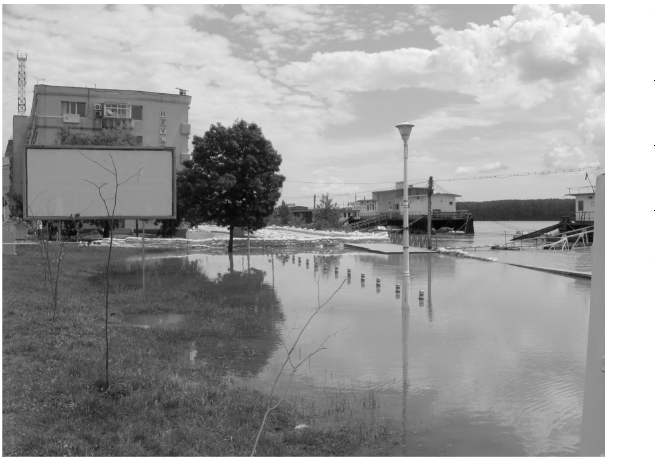
Figure 12. Flooding of the sea cliff and the NAVROM headquarters in Galati.